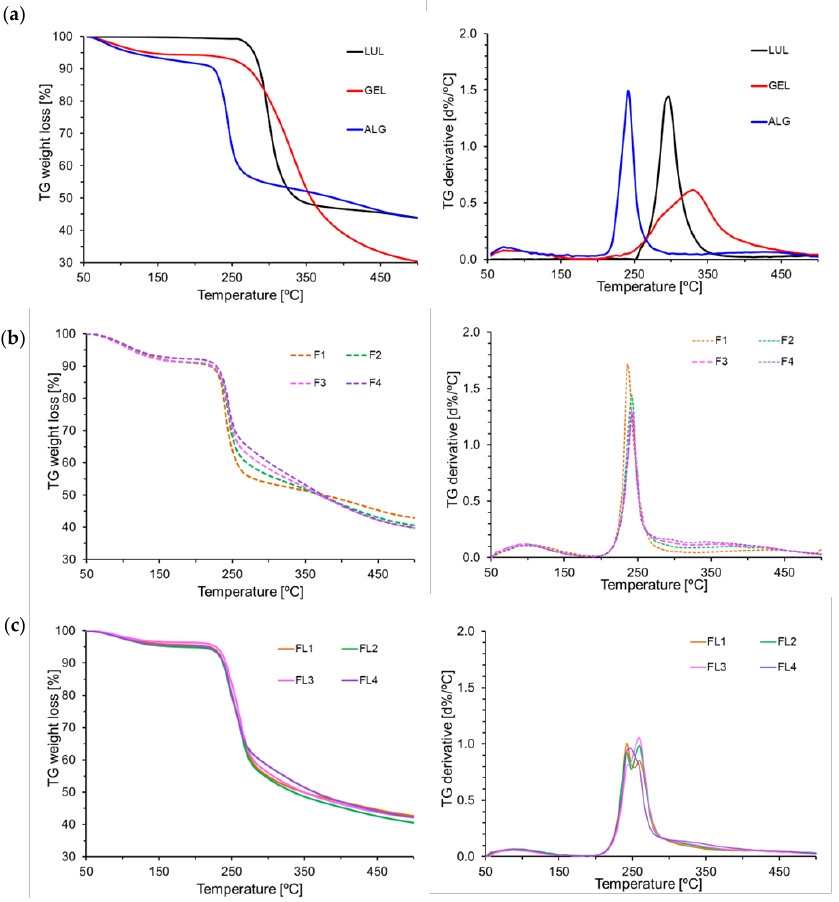
Figure 10. TGA curves of ( a ) ALG, GEL, and LUL, ( b ) placebo formulations (F1 – F4), and ( c ) LUL-loaded formulations (FL1 – FL4).